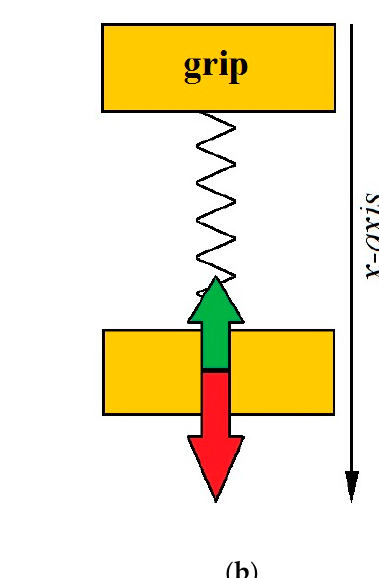
Figure 3 . Experiment and modeling: ( a ) Experimental and analytical relations of the elongation of a specimen from time and temperature; ( b ) Scheme of loading: Loading direction is indicated with the red arrow and the reaction force is depicted with the green arrow.